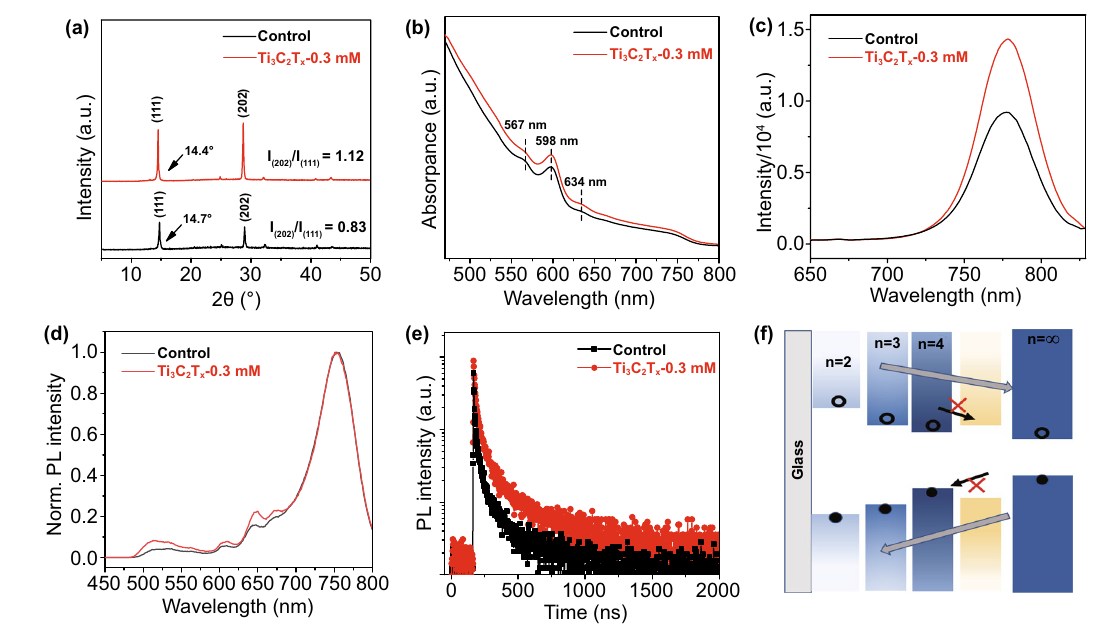
Fig. 4 a XRD patterns, b UV/Vis absorption spectra, c , d PL spectra excited from front and back side and e time‑resolved PL spectrums for the control and optimized Ti 3 C 2 T x ‑doping perovskite films (on ITO substrates). f Illustration of band structure of 2D perovskite